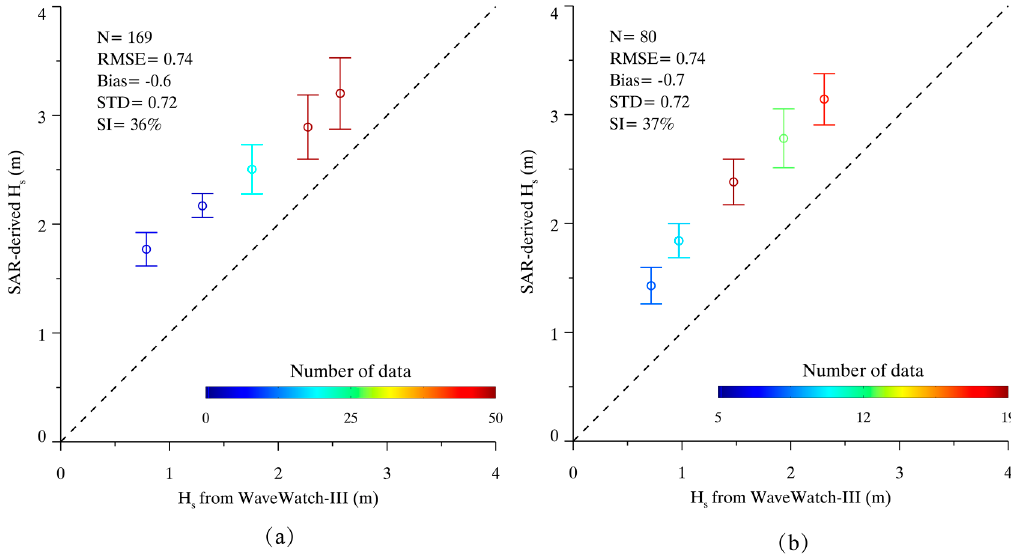
Figure 8. The comparison between SAR-derived SWH H s and WaveWatch-III data at 0.5 m/s bins. ( a ) Comparison of 96 VV-polarization GF-3 SAR images; and ( b ) Comparison of 70 HH-polarization GF-3 SAR images.